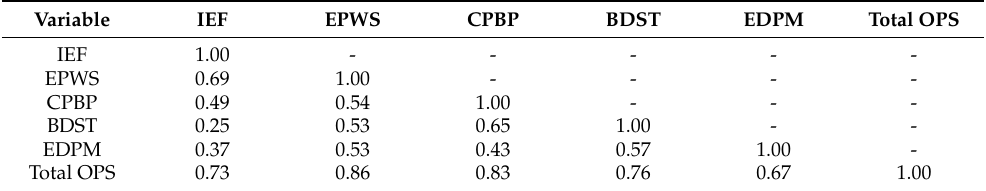
Table 6. The results of the Spearman correlation between scales of operational risk perception.